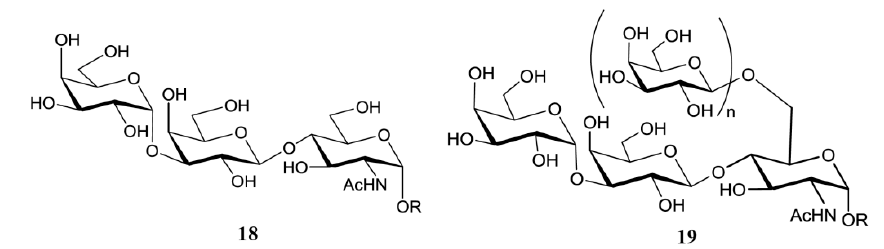
Figure 6. O -linked sugars in mucins of T. cruzi cell-derived trypomastigotes. 19 were assigned based on methylation analysis